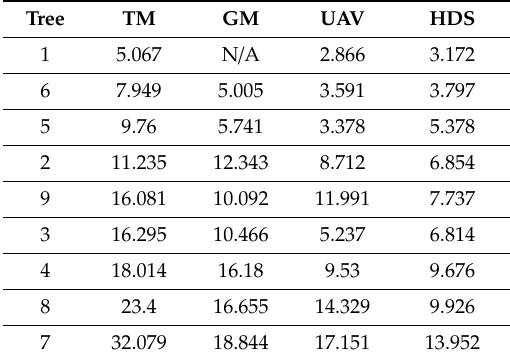
Figure 17. Cross-sections at di ff erent heights (above sea level) of tree 7 for TM and HDS (contour). ( A ) Cross-section at 22.4 m. ( B ) Cross-section at 23 m. ( C ) Cross section at 23.4 m. ( D ) Cross-section at 24 m. ( E ) Cross-section at 24.5 m. ( F ) Cross-section at 24.7 m. Table 2. Results of the crown volumes (m 3 ) of the orange trees with each of the methods studied.